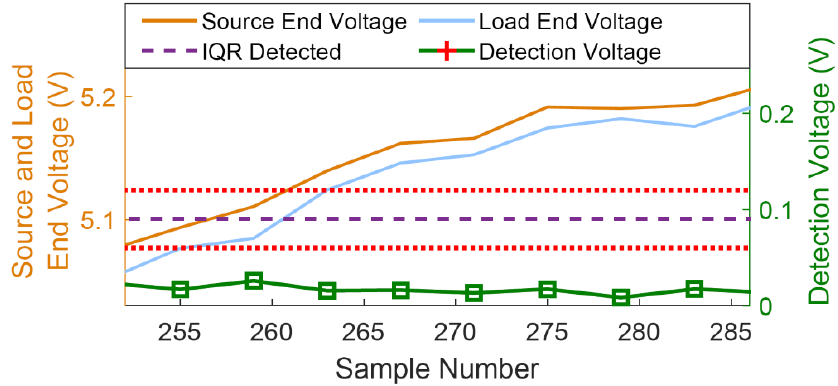
Figure 10. Event 3: detecting a series arc fault using the proposed method in the case of a sudden load change.